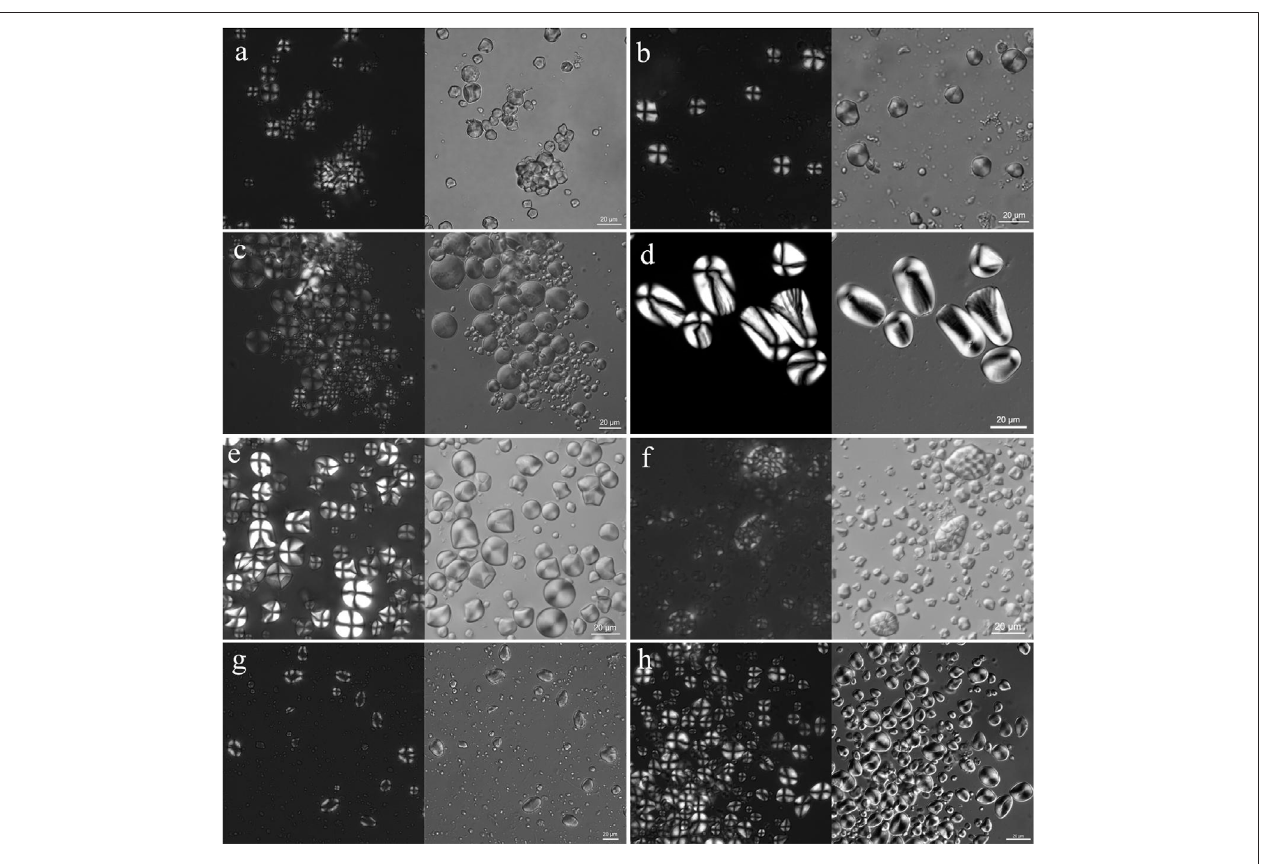
FIGURE 3 | Examples of starch grains morphology from the modern reference (scale bar: 20 μ m). (A) : Setaria italica ; (B) : Coix lacryma-jobi; (C) : Wheat; (D) : Nelumbo nucifera ; (E) : Trichosanthes kirilowii; (F) : Oryza sativa ; (G) : Leguminosae; (H) : Quercus sp.